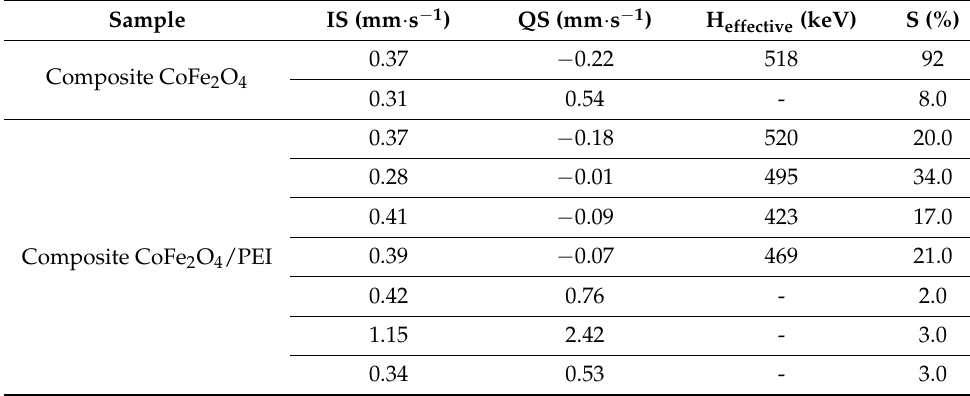
Table 2. Results of Mössbauer spectra of CoFe 2 O 4 , CoFe 2 O 4 /PEI composites.